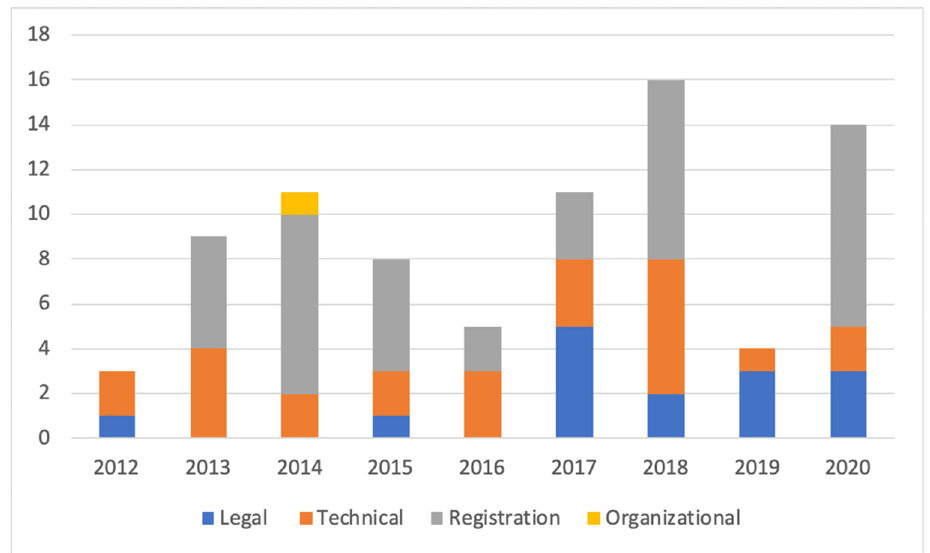
Figure 7. Distribution of LADM related standardization topics.